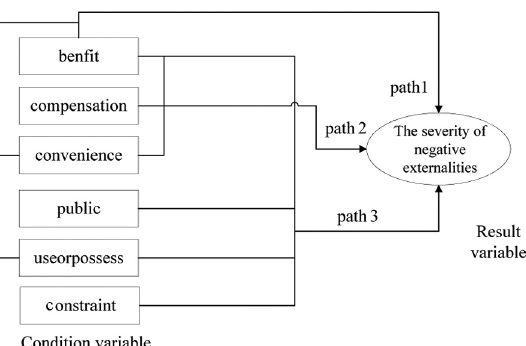
Figure 1. Schematic diagram of the general regression method